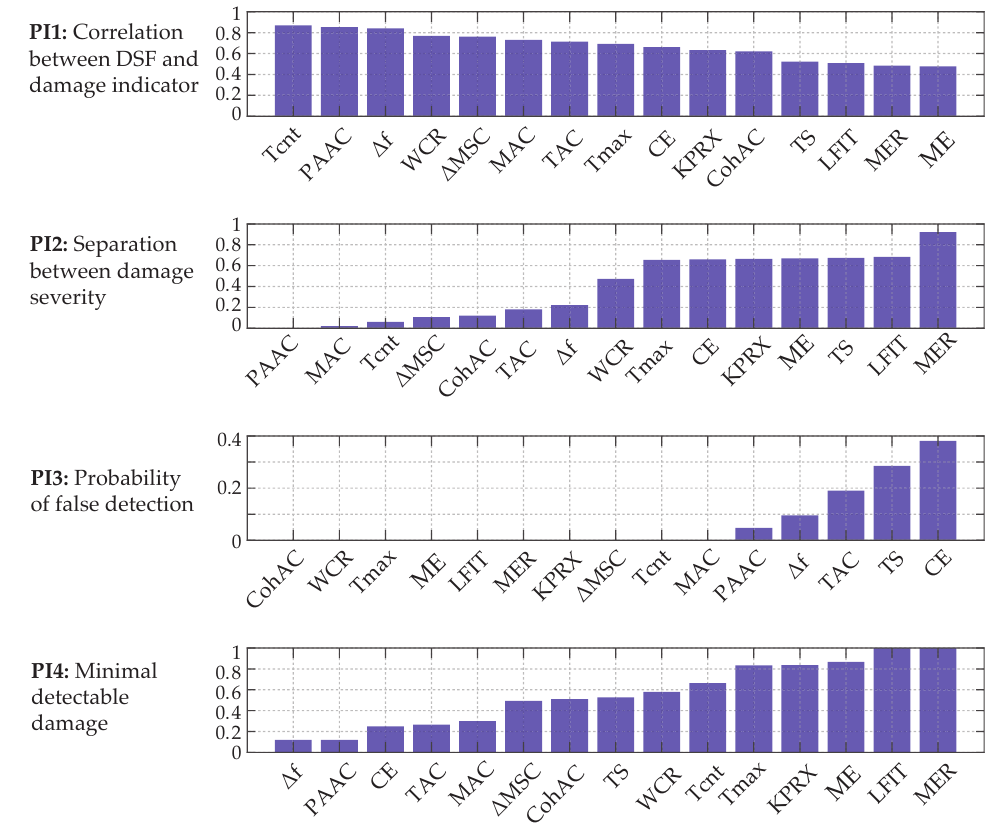
Figure 8. Evaluation of the damage detection and quantification performance of the DSFs: correlation between DSF and DI PA ( first row ), overlap of damage-state exceeding probabilities ( second row ), probability of false detection ( third row ), and smallest detectable damage level ( fourth row ). The performance indicators are derived as illustrated in Figure 5. All DSFs are evaluated for the first mode ( M 1) between the ground and the roof level (05); the indices are omitted to enhance readability.